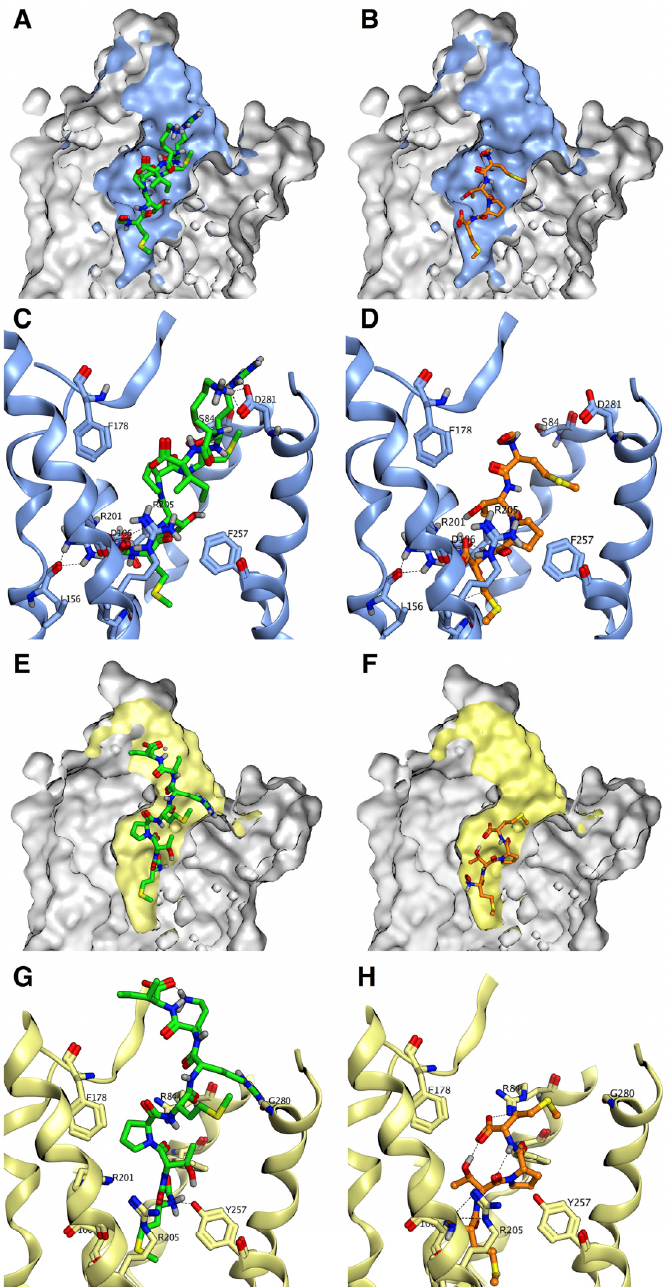
Figure 7. Molecular docking of MCT-2(1–7) and MCT-2(1–4) to FPR2 or FPR1. MCT-2(1–7) and MCT-2(1–4) are shown as green sticks and orange sticks, respectively. ( A , B ) The docking model of MCT-2(1–7) ( A ) and MCT-2(1–4) ( B ) to FPR2. ( C , D ) Detail of the ligand-binding cavity of FPR2. The structure of the ligand-binding cavity of FPR2 is shown in blue. ( E , F ) The docking model of MCT-2(1–7) ( E ) and MCT-2(1–4) ( F ) to FPR1. ( G , H ) Detail of the ligand-binding cavity of FPR1. The structure of the ligand-binding cavity of FPR1 is shown in yellow. Hydrogen bonding interactions are shown as dashed lines.